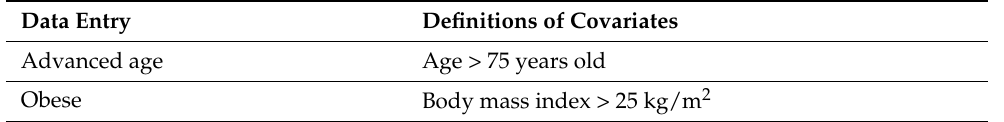
Table 1. Definitions of covariates for their effect on fluctuations in cerebral